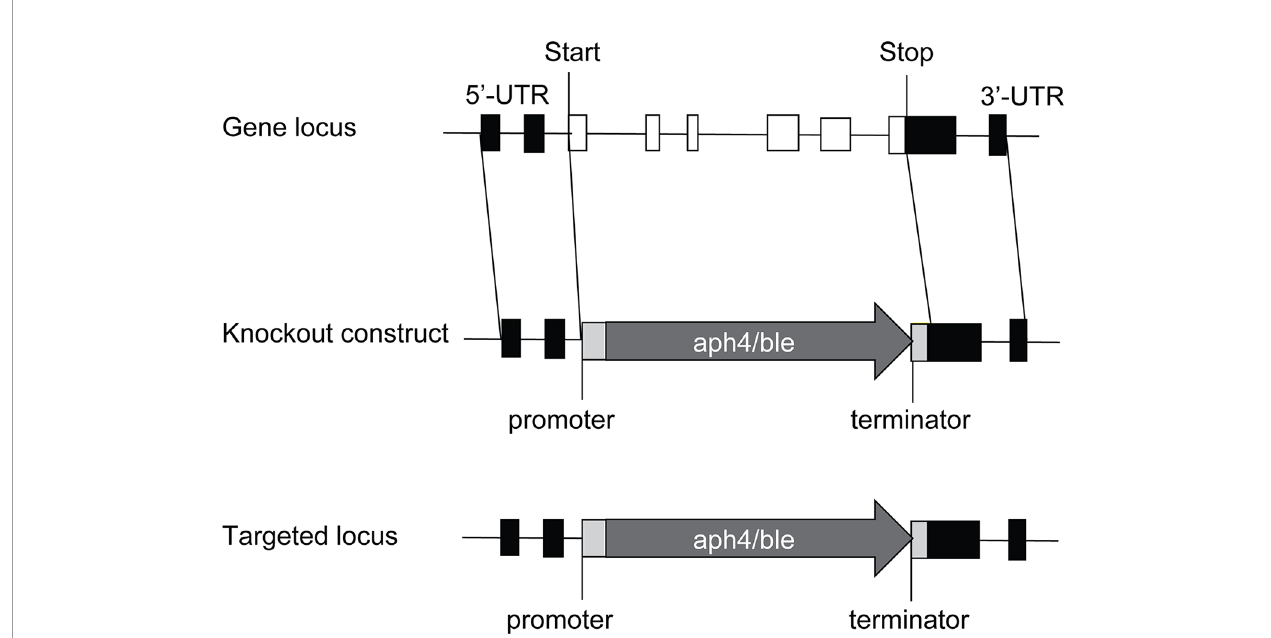
FIGURE 1 | Disruption of PpTPS1/PpTPS2 genes in P. patens . The PpTPS1 or PpTPS2 genes are replaced by the antibiotic resistance genes aph4 or ble , respectively. White boxes and black lines between the boxes represent exons and introns, respectively. Black boxes indicate UTR (untranslated region). Light gray boxes indicate promoter and terminator of the resistance gene. The dark gray arrows show the zeocin expression cassette (aph4) or the hygromycin expression cassette